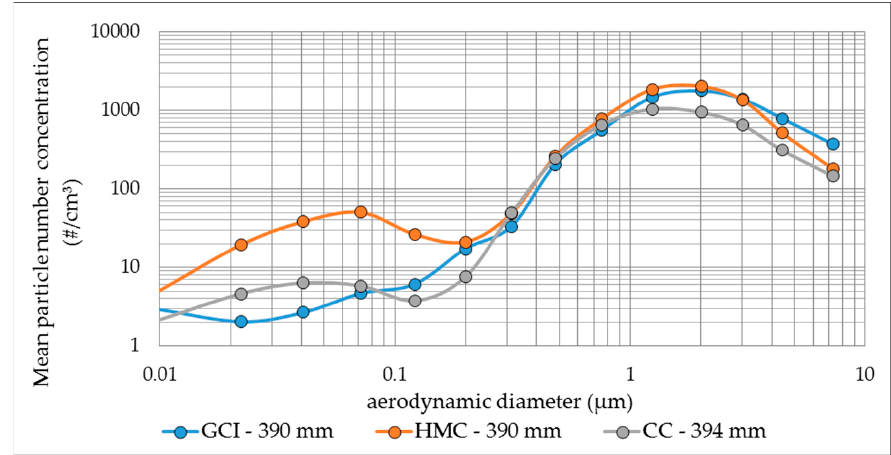
Figure 7. Mean particle size distribution of different friction materials (vehicle 1)—WLTP brake cycle trip #10.